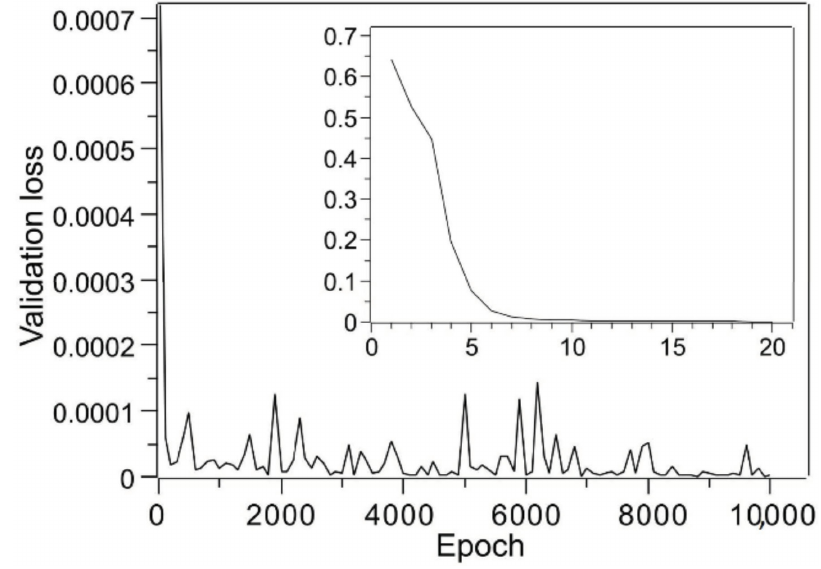
Figure 2. Changes in validation loss with respect to epochs based on training using the two-layer compression data shown in Table 1. The results for the first 20 epochs are displayed as an